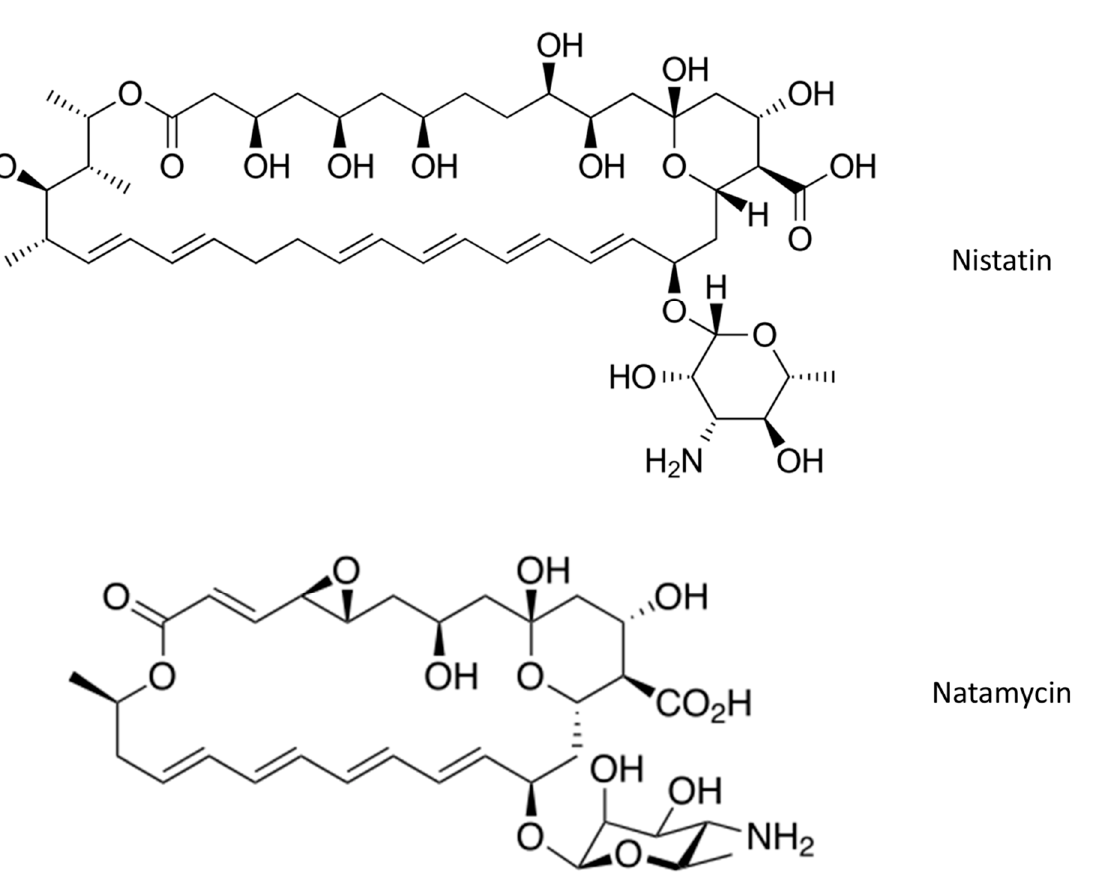
Figure 1. Chemical structures of nystatin and natamycin.